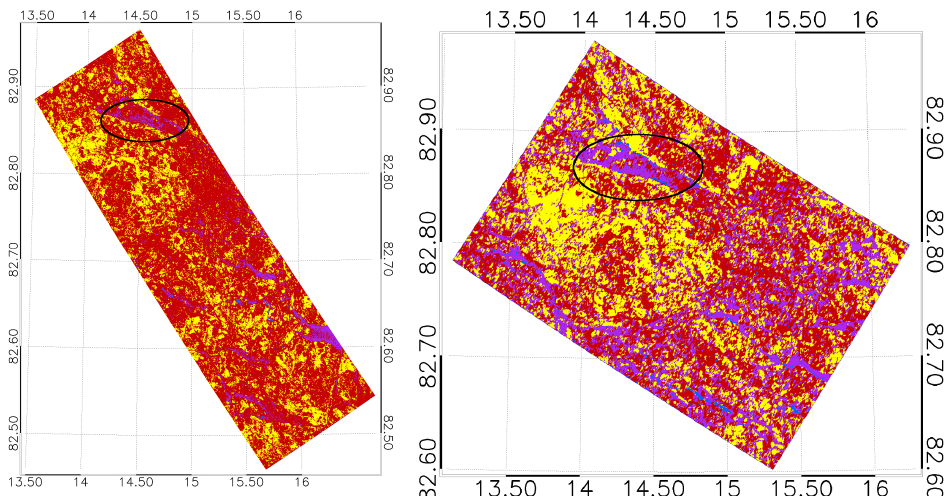
Figure 10. Comparison of classification results. For orientation, black ellipses indicate same ice structures. ( Left ) ice classification of TS-X acquisition on 19 April 2015; ( Right ) ice classification of RS-2 acquisition on 19 April 2015. Blue: Open Water/nilas (OW), purple: Young Ice (YI), yellow: first year ice (SFYI), red: rough first year ice/multi-year ice